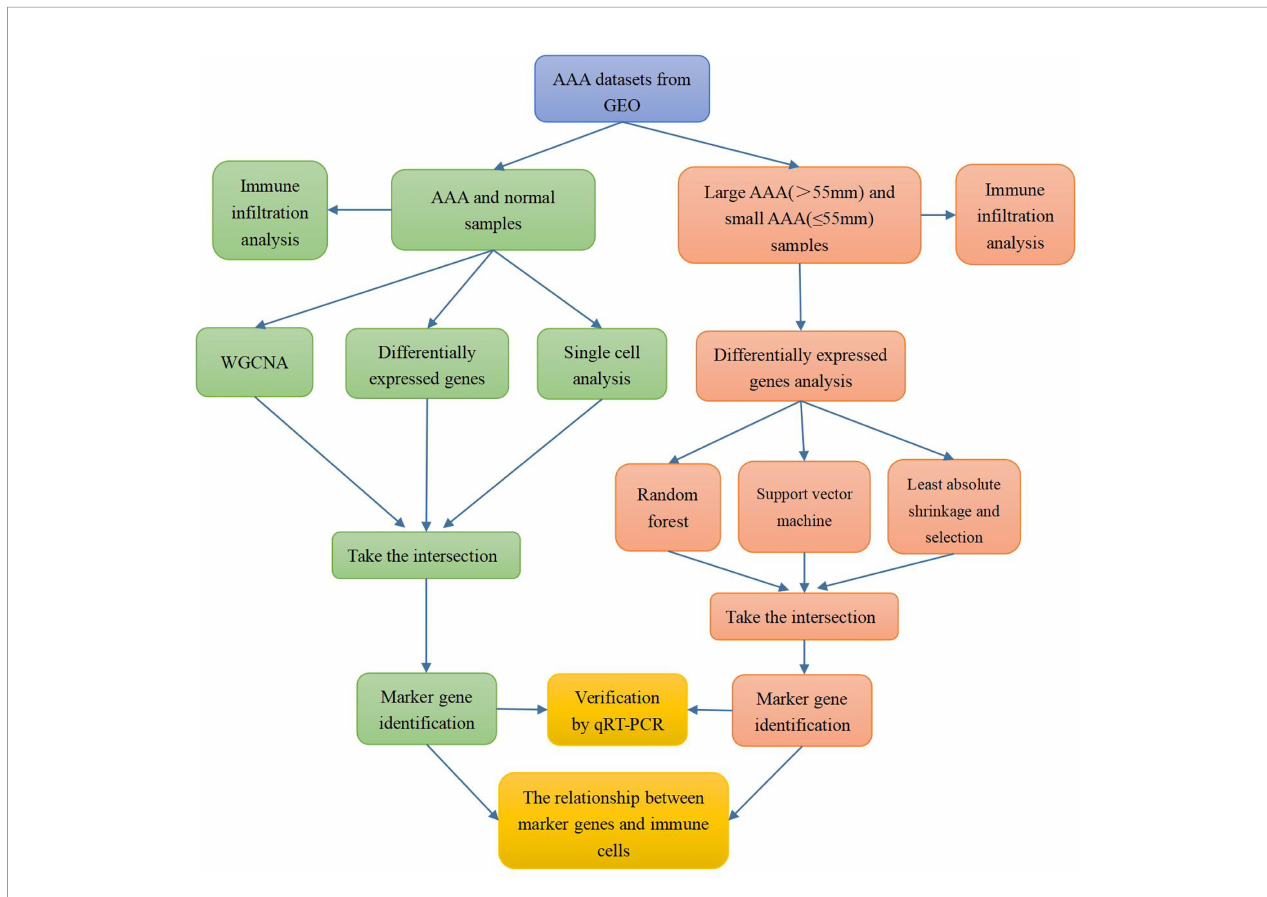
FIGURE 1 | Flow chart of the research